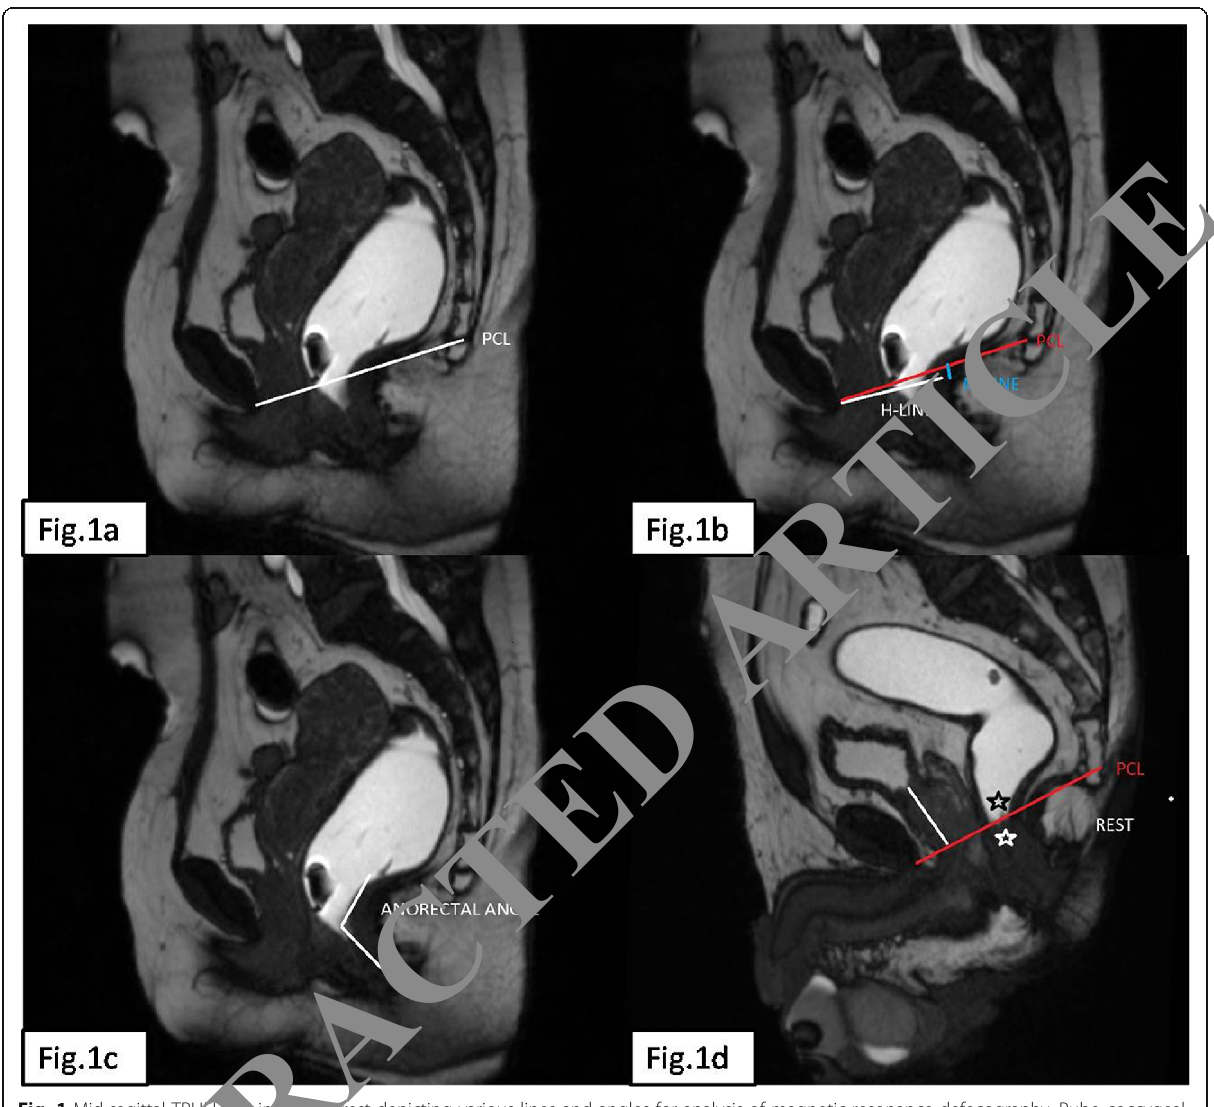
Fig. 1 Mid sagittal TRUFI MRI images at rest depicting various lines and angles for analysis of magnetic resonance defecography. Pubo-coccygeal line (PCL) is drawn from last coccygeal joint to inferior margin of pubis ( a ) with H (hiatal) line drawn from inferior border of pubis to ano-rectal junction ( b ). The angle formed between long axis of anal canal and posterior rectal wall is called ano-rectal angle and is normally obtuse at rest ( c ). At rest, ano-rectal angle and bladder neck lie above PCL ( d )